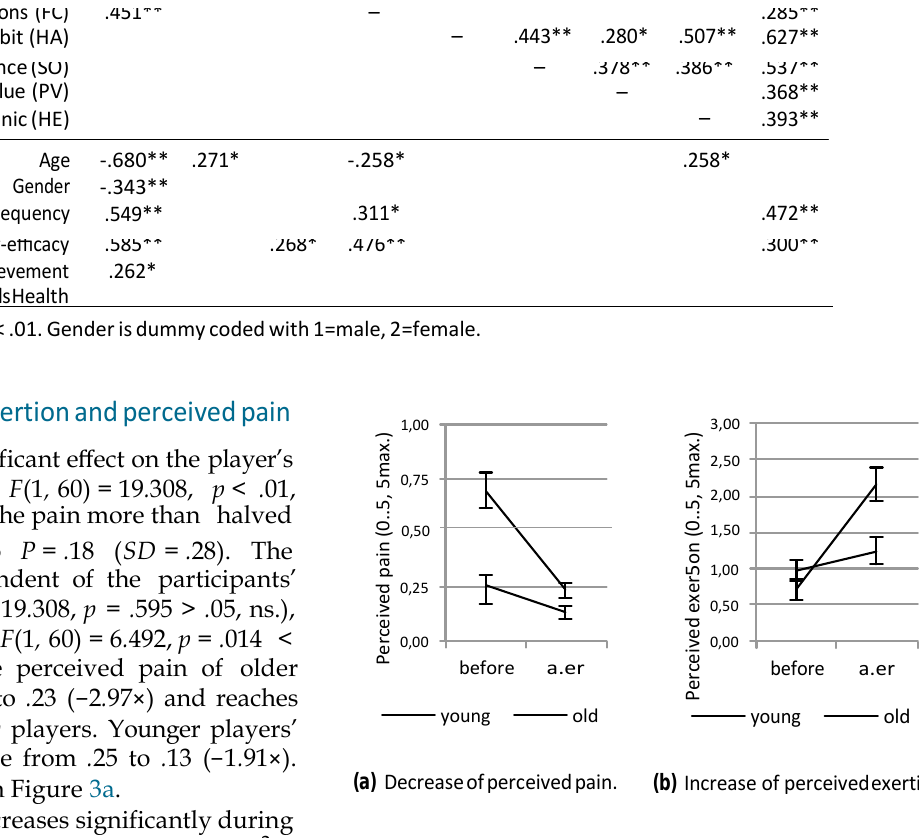
Figure 3. Change of perceived exertion and perceived pain for older and younger users before and after the